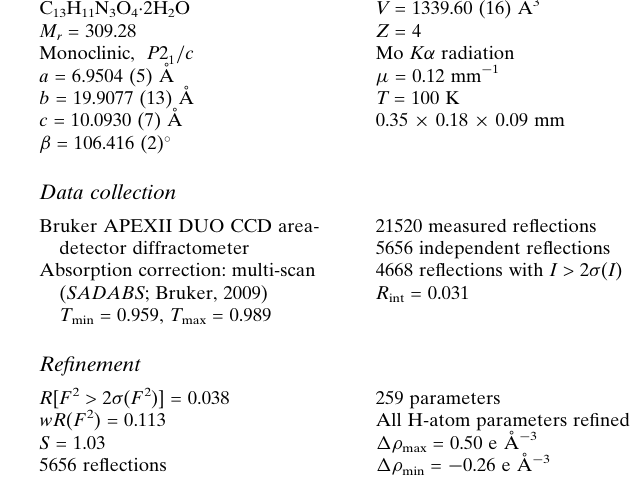
21520 measured reflections 5656 independent reflections